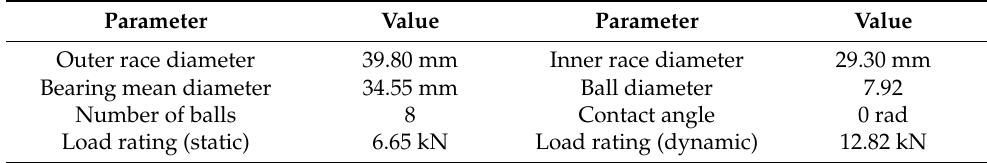
Table 1. Parameters of the tested bearings.